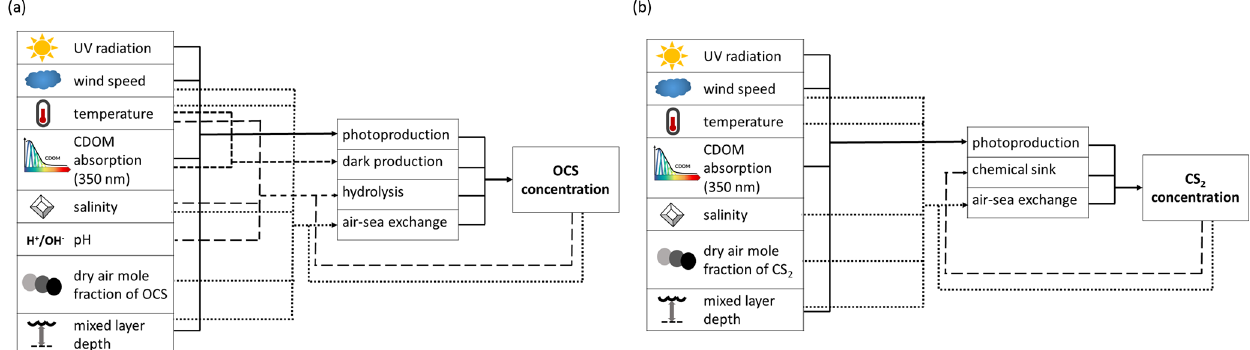
Figure 1. Schematic overview of processes and forcing included in the box models for (a) OCS and (b) CS 2 .